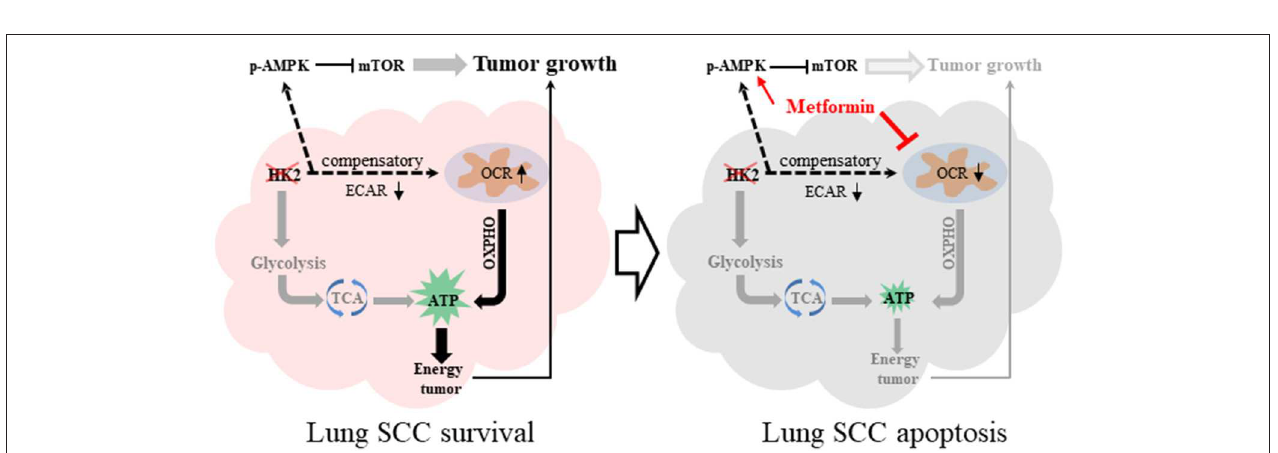
FIGURE 6 | with that in H226 si-HK2-transfected cells with or without metformin treatment. (E) The colony formation numbers in H226 si-NC- and H226 si-HK2-transfected cells with or without metformin treatment. (F) Colony formation assay showing the anchorage-independent growth in H520 si-NC-transfected cells compared with that in H520 si-HK2-transfected cells with or without metformin treatment. (G) The colony formation numbers in H520 si-NC- and H520 si-HK2-transfected cells with or without metformin treatment. (H) Tumor volumes were assessed in A226-siNC/siHK2-3# cells with or without treatment of metformin. Nude mice were injected with cells (5 × 10 6 cells, n = 5), cells were mixed in Matrigel, and tumor volumes of the different treatment groups were measured as indicated. (I) Tumor pictures are shown for A226-siNS/siHK2-3# cells with or without treatment of metformin. (J) Tumor weight was assessed in A226-siNC/siHK2-3# cells with or without treatment of metformin. * p < 0.05, ** p < 0.01, *** p < 0.001.